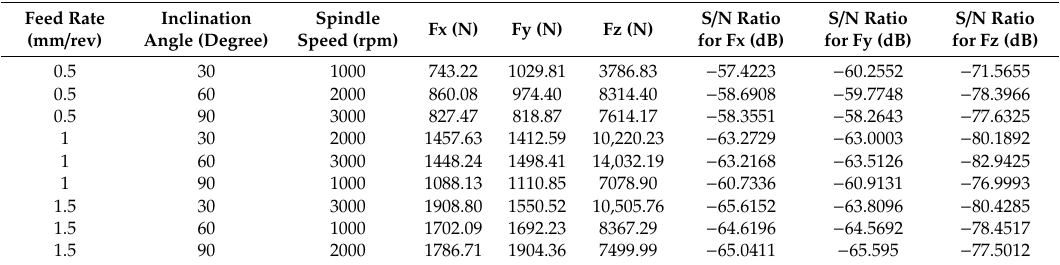
Table 5. The measured cutting force responses and the corresponding signal to noise ratios.